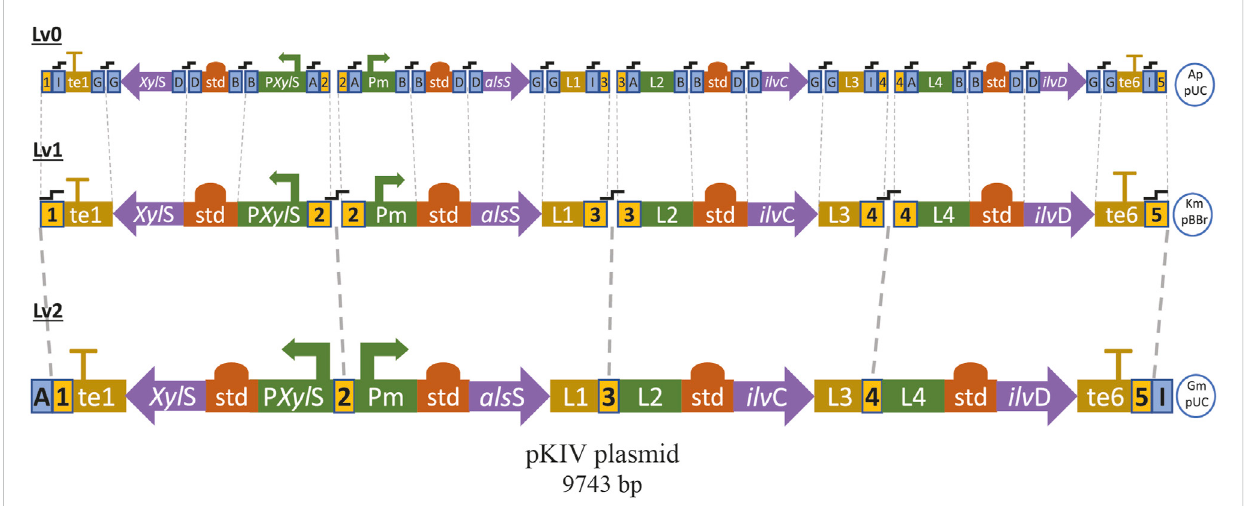
FIGURE 7 Sequential modular assembly of pKIV plasmid from basic DNA parts by using Golden Standard (See method). te1: T1 Terminator, L1, L2, L3 and L4: linker terminals and promoters, te6: BBa B1006 Terminator, std: consensus RBS, Ap: ampicillin resistance, Km: kanamycin resistance, Gm: gentamycin resistance, fusion sites of BsaI (blue square) and BpiI (yellow square) enzymes.